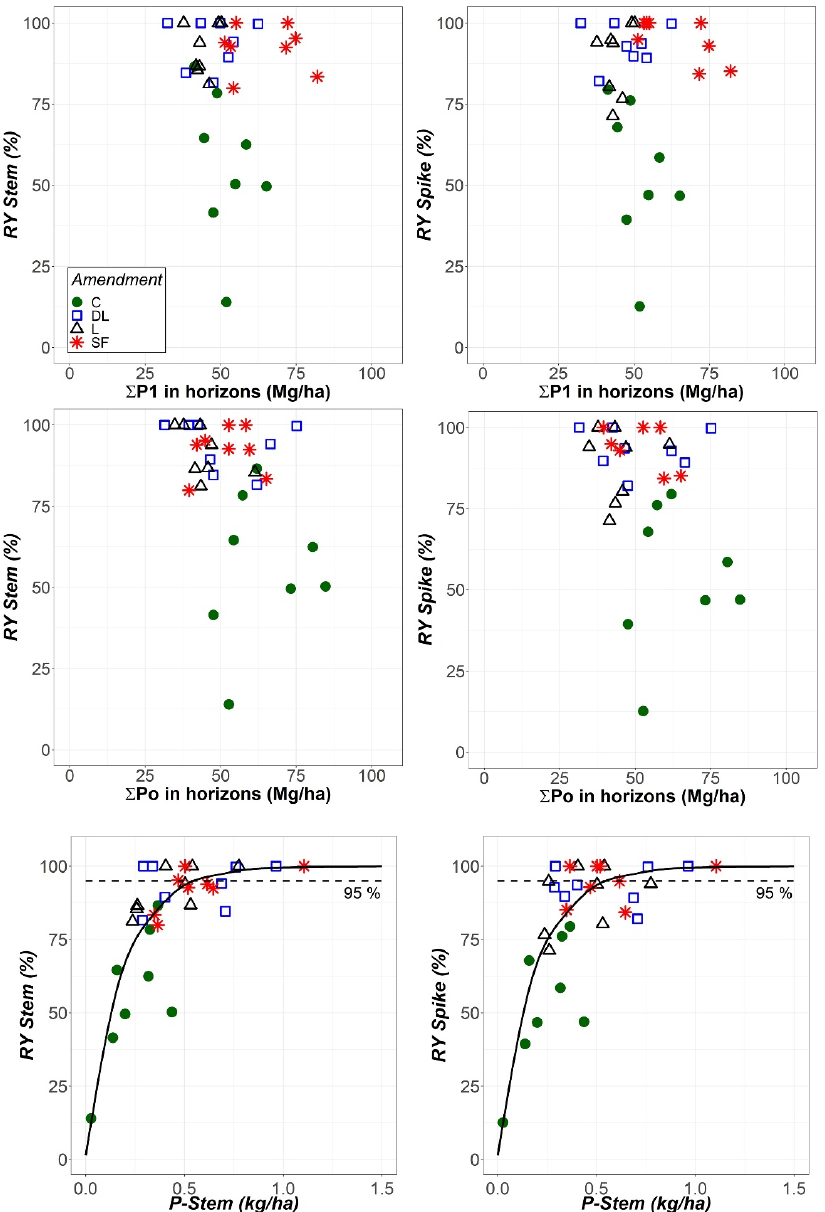
Figure 8. Relationship between the relative yields of stems (RY Stem) and spikes (RY Spike) and the sum of total soil available P in the Ap1 and Ap2 horizons as determined by using the Bray-1 and Olsen methods (P1 and Po, respectively), as well as between both RY Stem and RY Spike and the P content in stems (P-Stem) at the harvest stage. All results are expressed as a function of the liming treatment (control (C), dolomitic limestone (DL), limestone (L) and sugar foam (SF)) as indicated in upper left panel. Mitscherlich curves passing through the origin were fit to the data of RY against